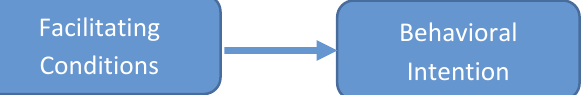
Fig. 4. Facilitating relationships Condition and Behavioral Intention Source (Tahrini, 2015)